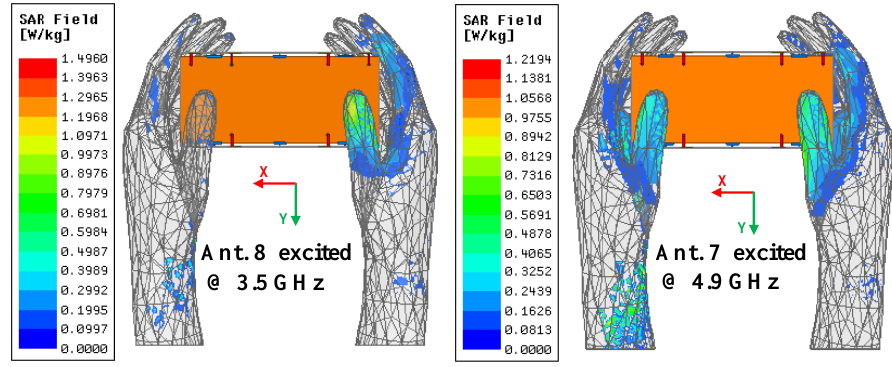
Figure 8. SAR field distribution.